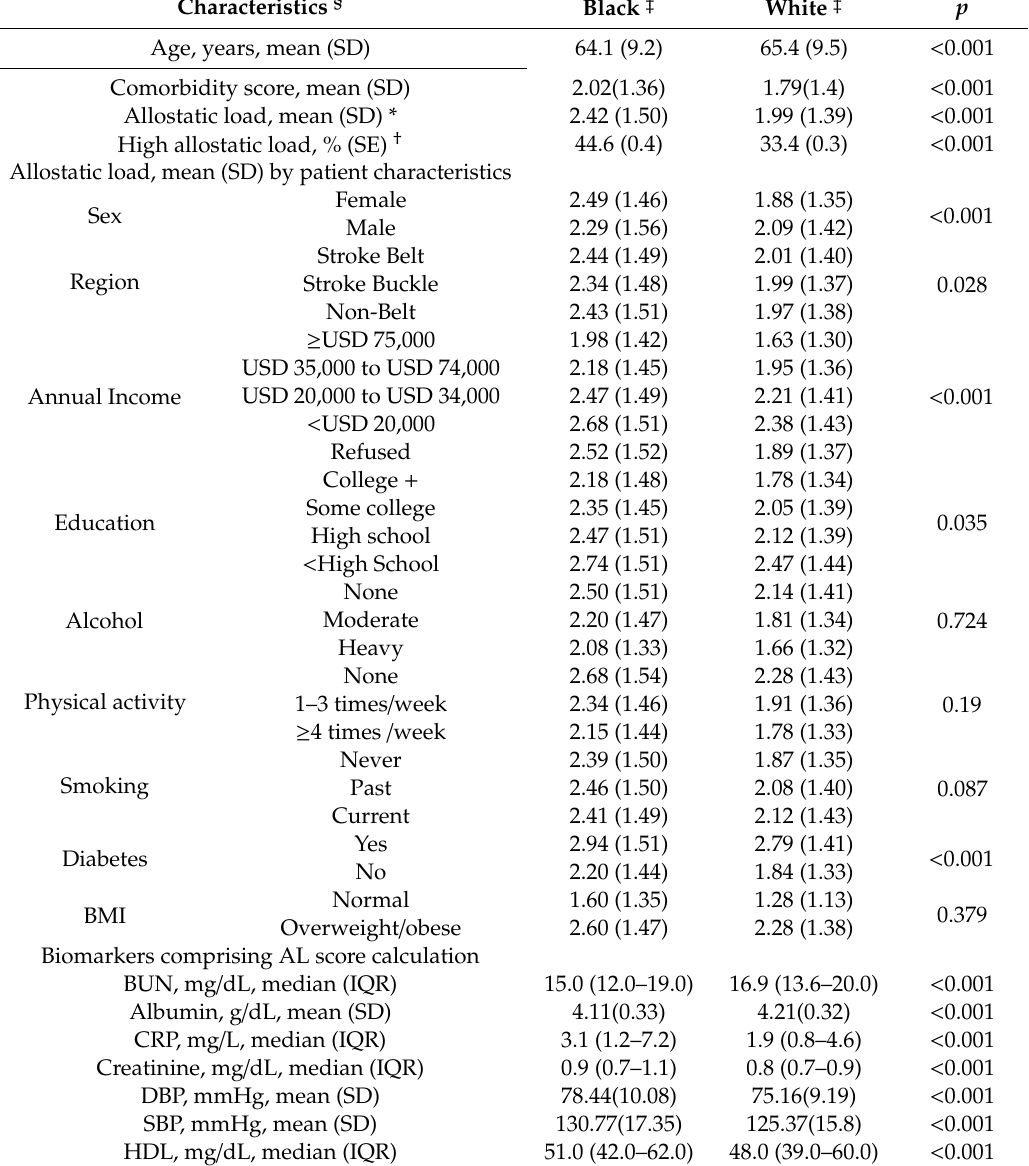
Table 1. Study characteristics § and Mean Allostatic Load Score ‡ stratified by Race in the REGARDS cohort ( N =